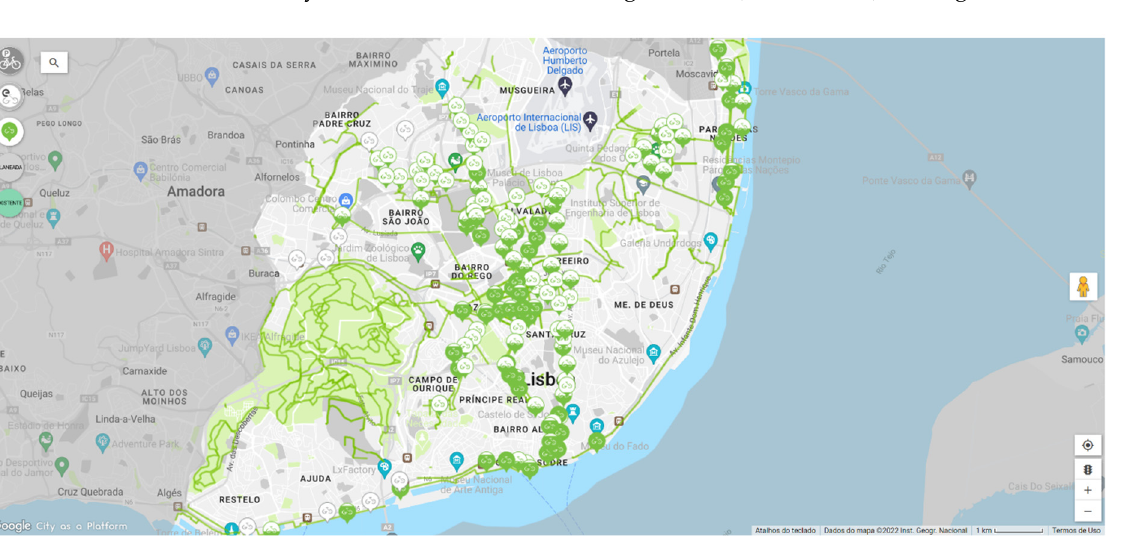
Figure 1. GIRA e-bike technical specifications.